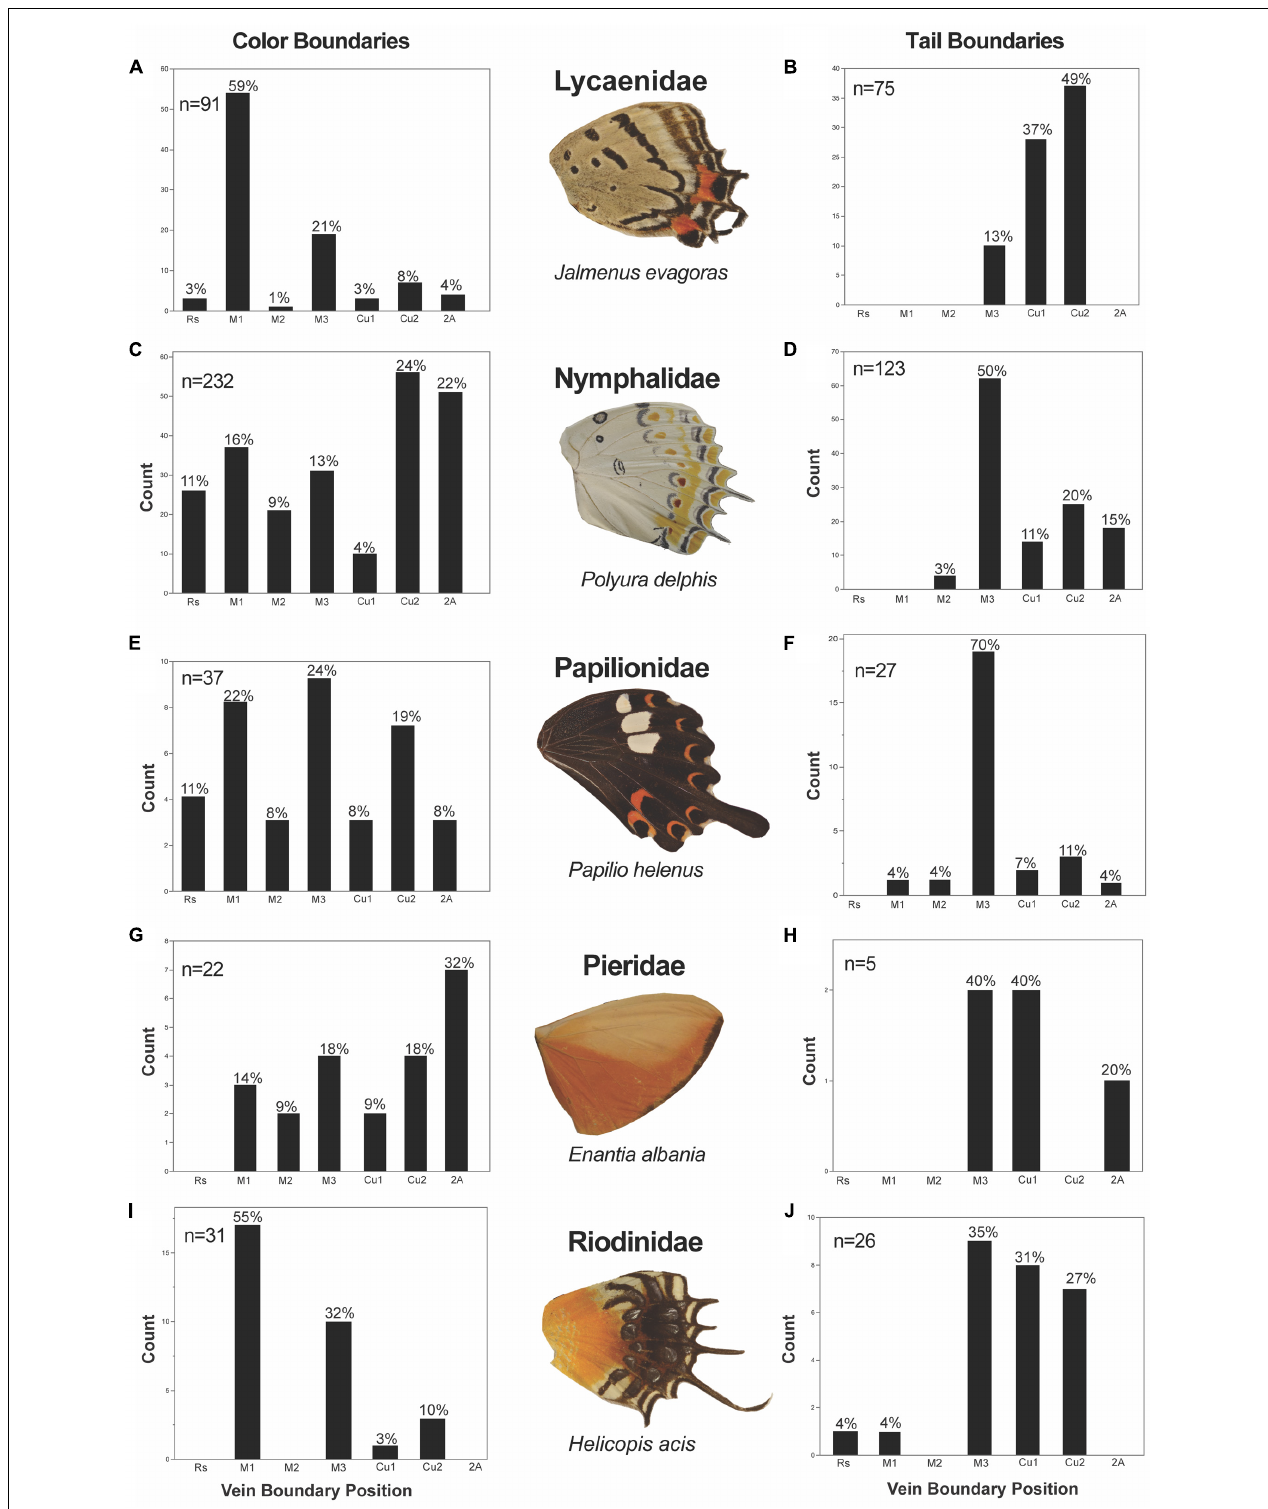
FIGURE 8 | Color pattern heterogeneity and tail occurrence frequency subdivided by Family. There is Family level variation in the position at which color boundaries and tails occur. The color boundaries in Lycaenidae (A) and Riodinidae (I) occur most frequently at M1, while color boundaries appear more frequently posterior to M3 in Nymphalidae (C) and Pieridae (G) . In Papilionidae (E) , color discontinuities occur most frequently at M3 and equally so at M1 and Cu2. Tails appear most frequently at M3 from all Families (D,F,H,J) , but Lycaenidae (B) .